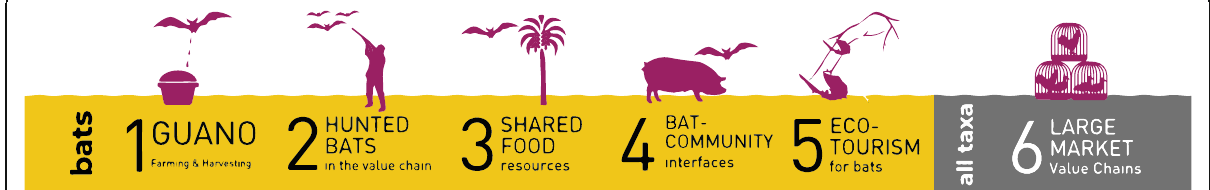
Fig. 4 Bat-specific interfaces investigated by One Health surveillance teams. Several bat-specific interfaces were investigated by PREDICT ’ s One Health surveillance teams and explored in-depth through our human behavioral risk investigations. Large market value chains were a principal area of interest in relation to all wildlife